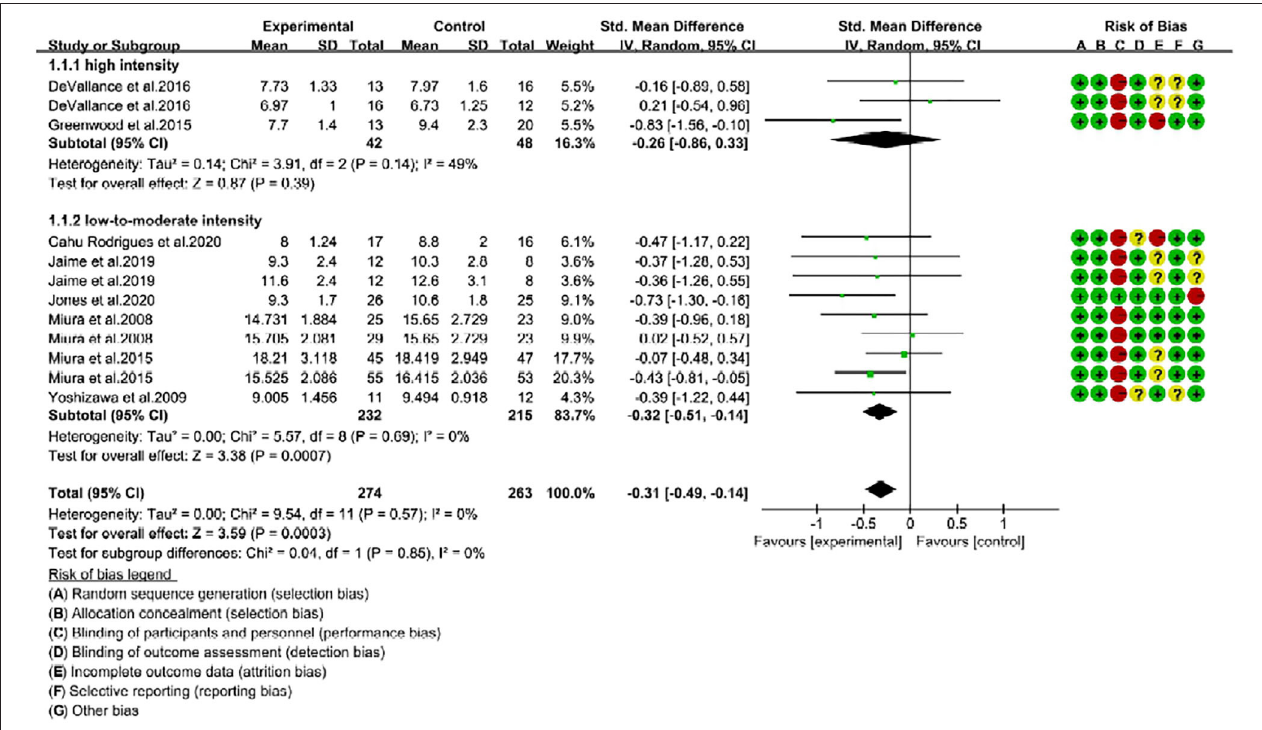
FIGURE 4 | Forest plot of pulse wave velocity (PWV) changes with different intensities of RE in middle-aged adults (m/s). SD, standard deviation; IV, inverse variation; CI, confidence interval; df, degrees of freedom. Risk of bias: green ( + ) indicates low risk of bias; red (–) high risk of bias; and yellow (?) unclear risk of